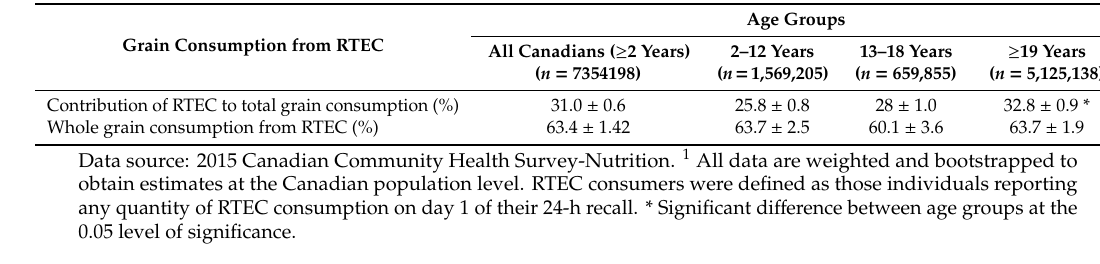
Table 6. Percentages of grain consumption from RTEC among RTEC consumers 1